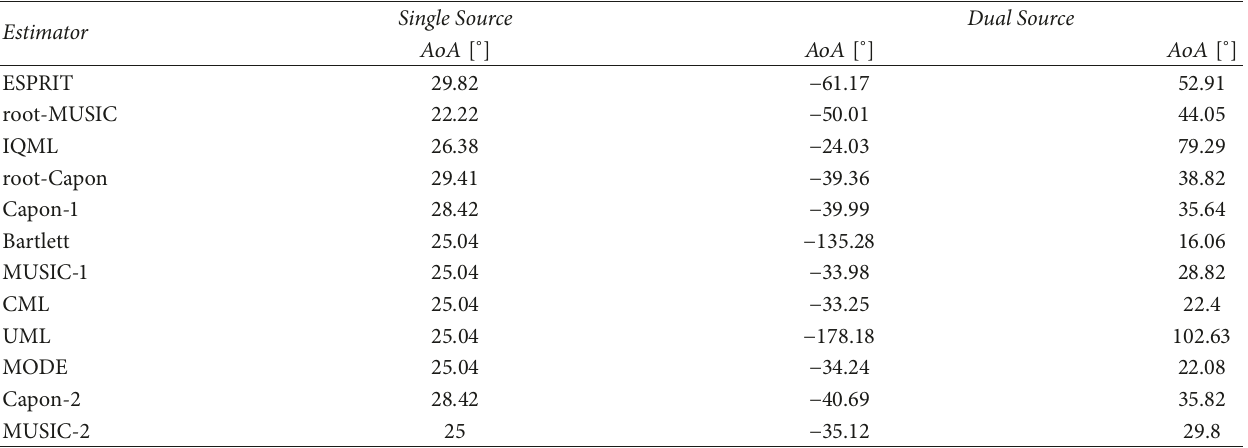
Table 5: Estimated AoAs without array calibration. The setup is a single source (25 ∘ ) and a coherent dual source ( − 30 ∘ , 25 ∘ ) scenario.